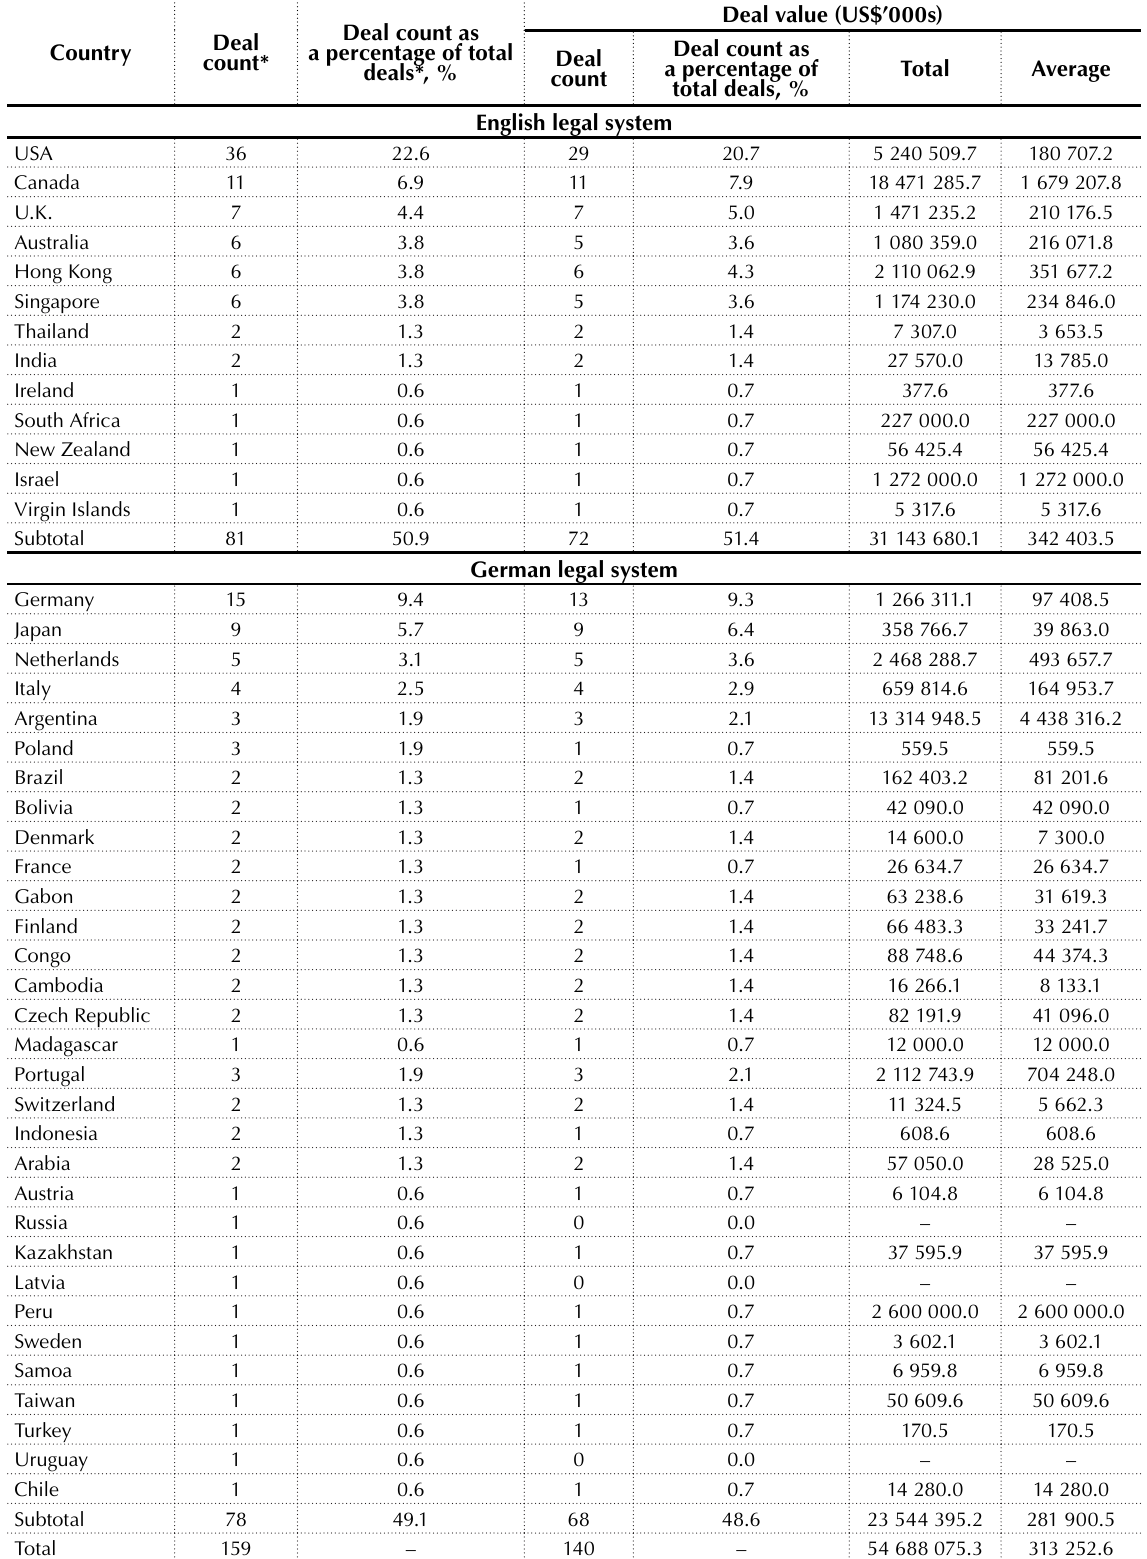
Table 2. Cross-border acquisitions by Chinese firms by the legal systems of target countries Deal value (US$’000s) Deal count as Deal Deal count as Country a percentage of total Deal count* a percentage of Total Average deals*, % count total deals, % English legal